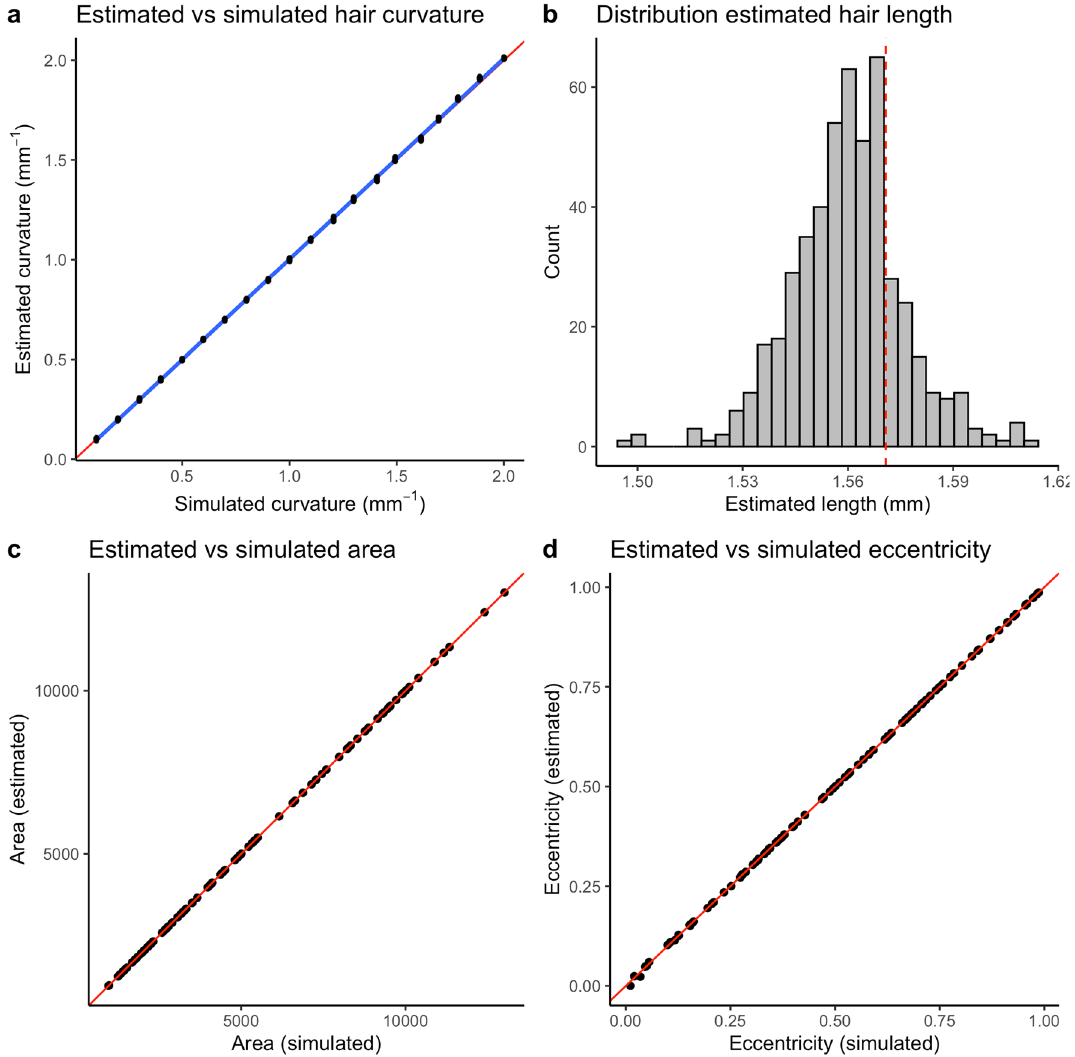
Figure 4. Performance of fibermorph on simulated data. ( a ) Correlation between estimated and true curvature. The red line represents y = x and the blue line represents the line of best fit. ( b ) Distribution of hair fragment length estimates. The dashed red line shows the true simulated length of each fragment. ( c ) Correlation between estimated and true cross-sectional area. ( d ) Correlation between estimated and true